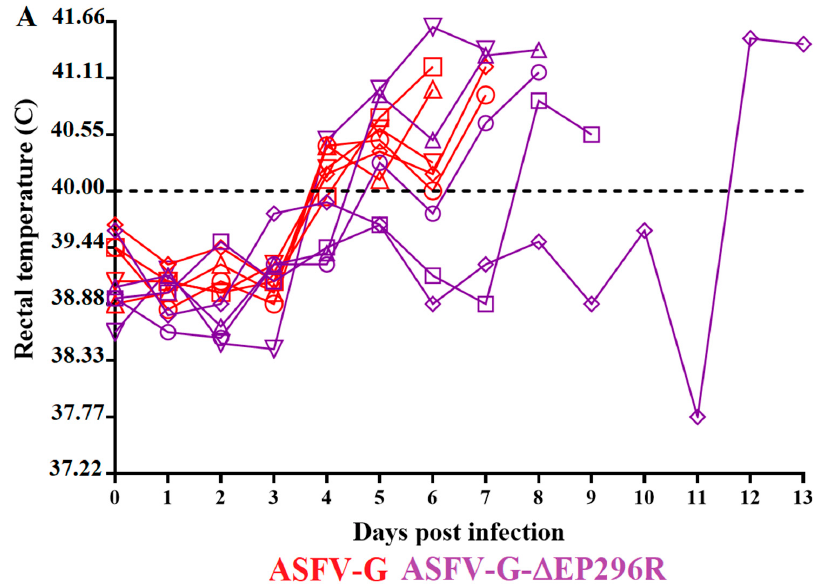
Figure 6. Evolution of body temperature in animals (five animals/group) IM infected with 10 2 HAD 50 of either ASFV-G- ∆ EP296R or parental ASFV-G. No significant differences in the evolution of body temperature were found between groups when analyzed by the unpaired t -test using the two-stage step-up (Benjamin, Krieger, and Yekutieli) method.